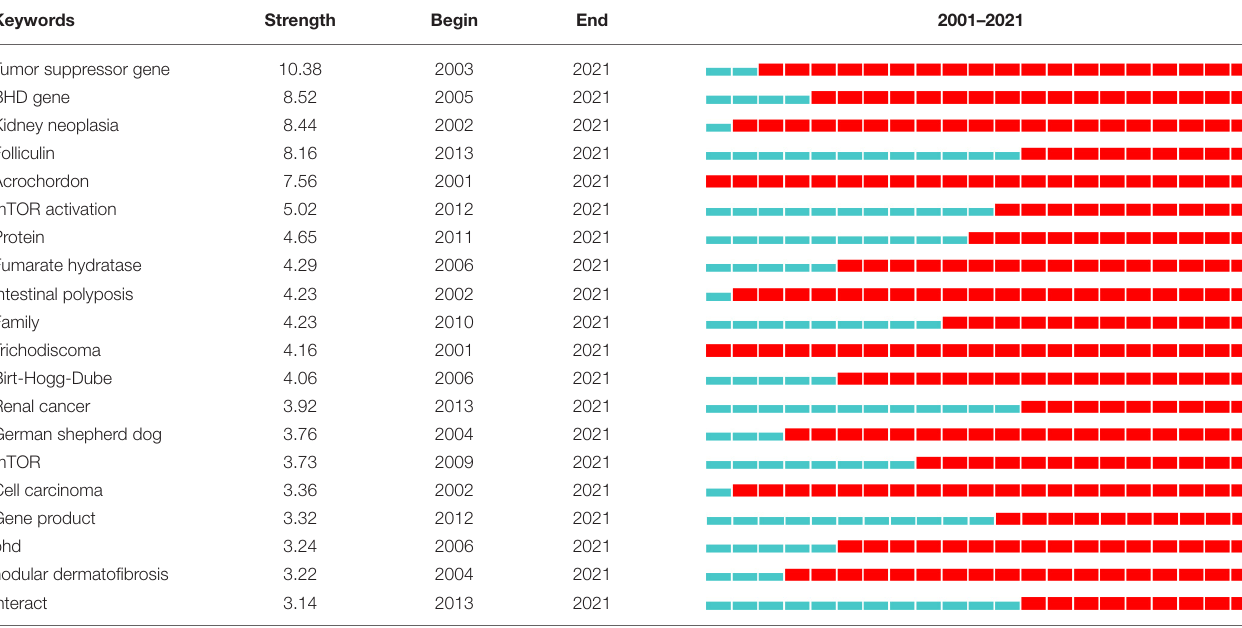
TABLE 8 | Top 20 keywords with the strongest citation bursts.